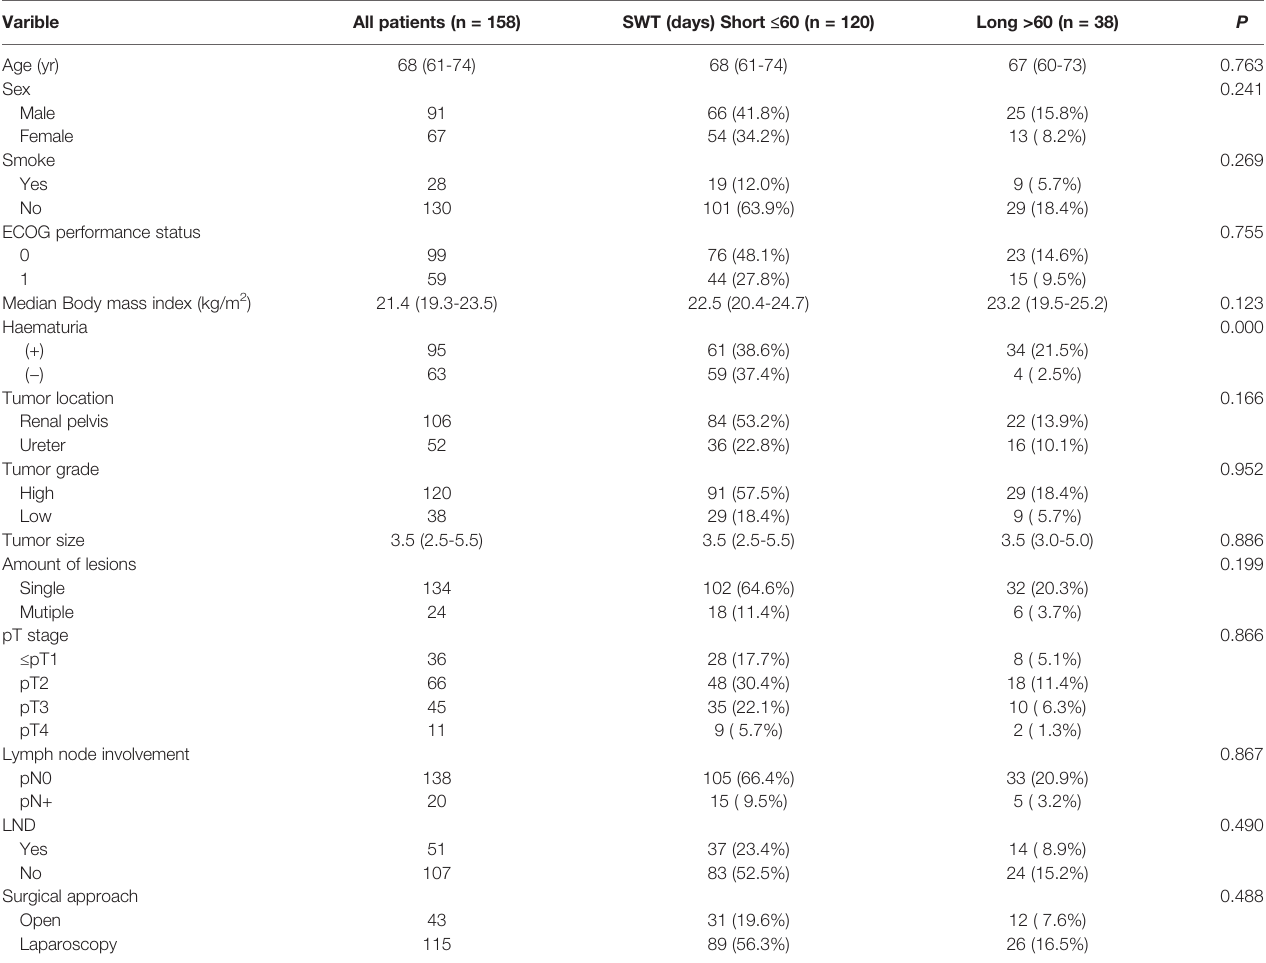
TABLE 2 | Clinical characteristics of patients in the short-, and long-wait groups. Varible All patients (n =